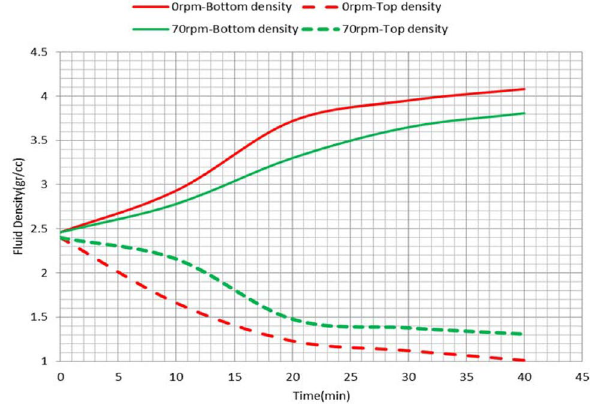
Fig. 4 Changes in the concentration of barite particles in the upstream and downstream of the circulating loop (flow rate of 0.190 l/s and deviation angle of 45 o )